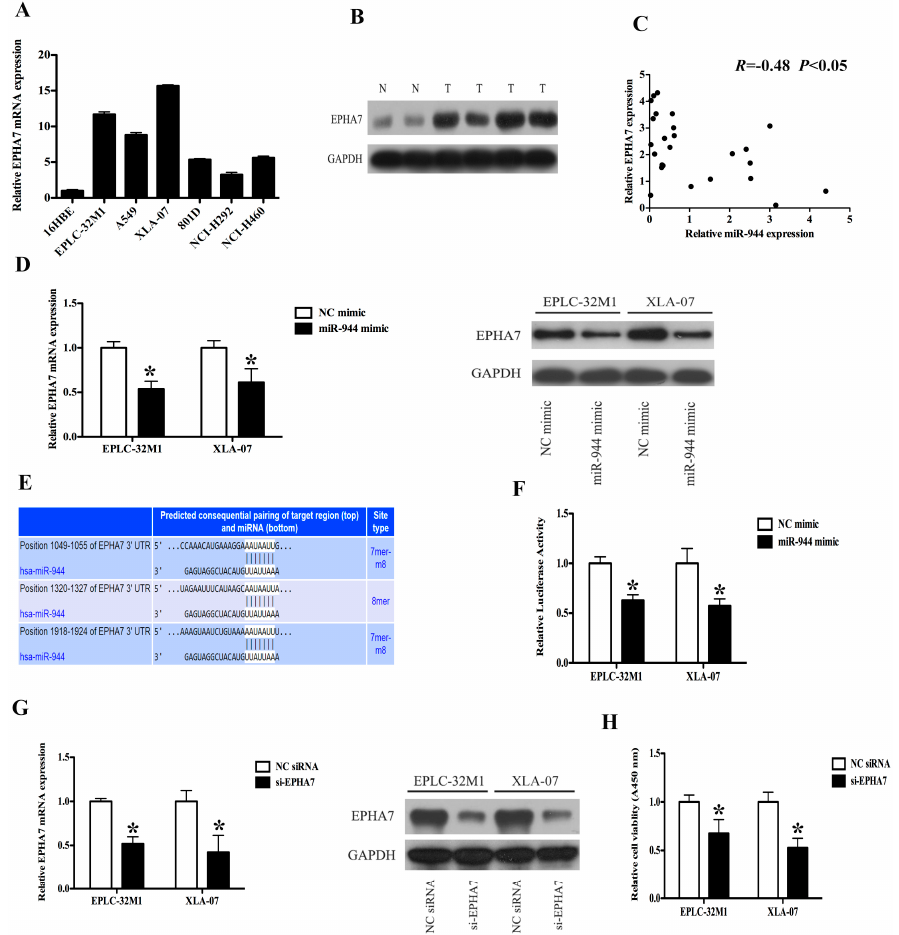
Figure 4. EPHA7 is a direct target of miR-944 in NSCLC. ( A ) The expressions of EPHA7 were examined by qRT-PCR in NSCLC cell lines; ( B ) The expressions of EPHA7 were examined by western blot in NSCLC tissues and noncancerous lung tissues; ( C ) The relationships between miR-944 and EPHA7 protein levels were analyzed using Pearson’s method in NSCLC tissues, R = − 0.48, p < 0.05; ( D ) The mRNA and protein levels of EPHA7 were measured in EPLC-32M1 and XLA-07 cells transfected with the miR-944 mimic and negative control (NC); ( E ) Sequences of the putative miR-944 binding sites; ( F ) The relative luciferase activity was determined using luciferase reporters with EPHA7-3 ′ UTR in EPLC-32M1 and A549 cells transfected with the miR-944 mimic and negative control (NC); ( G ) The EPHA7 expression was analyzed using qRT-PCR and western blot in EPLC-32M1 and XLA-07 cells transfected with the siRNA (si-EPHA7) and negative control (NC); ( H ) The proliferation rates were analyzed using proliferation assay in EPLC-32M1 and XLA-07 cells after transfection with the siRNA (si-EPHA7) and negative control (NC). GAPDH was used as an internal control ( B , D , G ). The significance was evaluated by t -test ( A , B , D , F – H ), * p < 0.05.